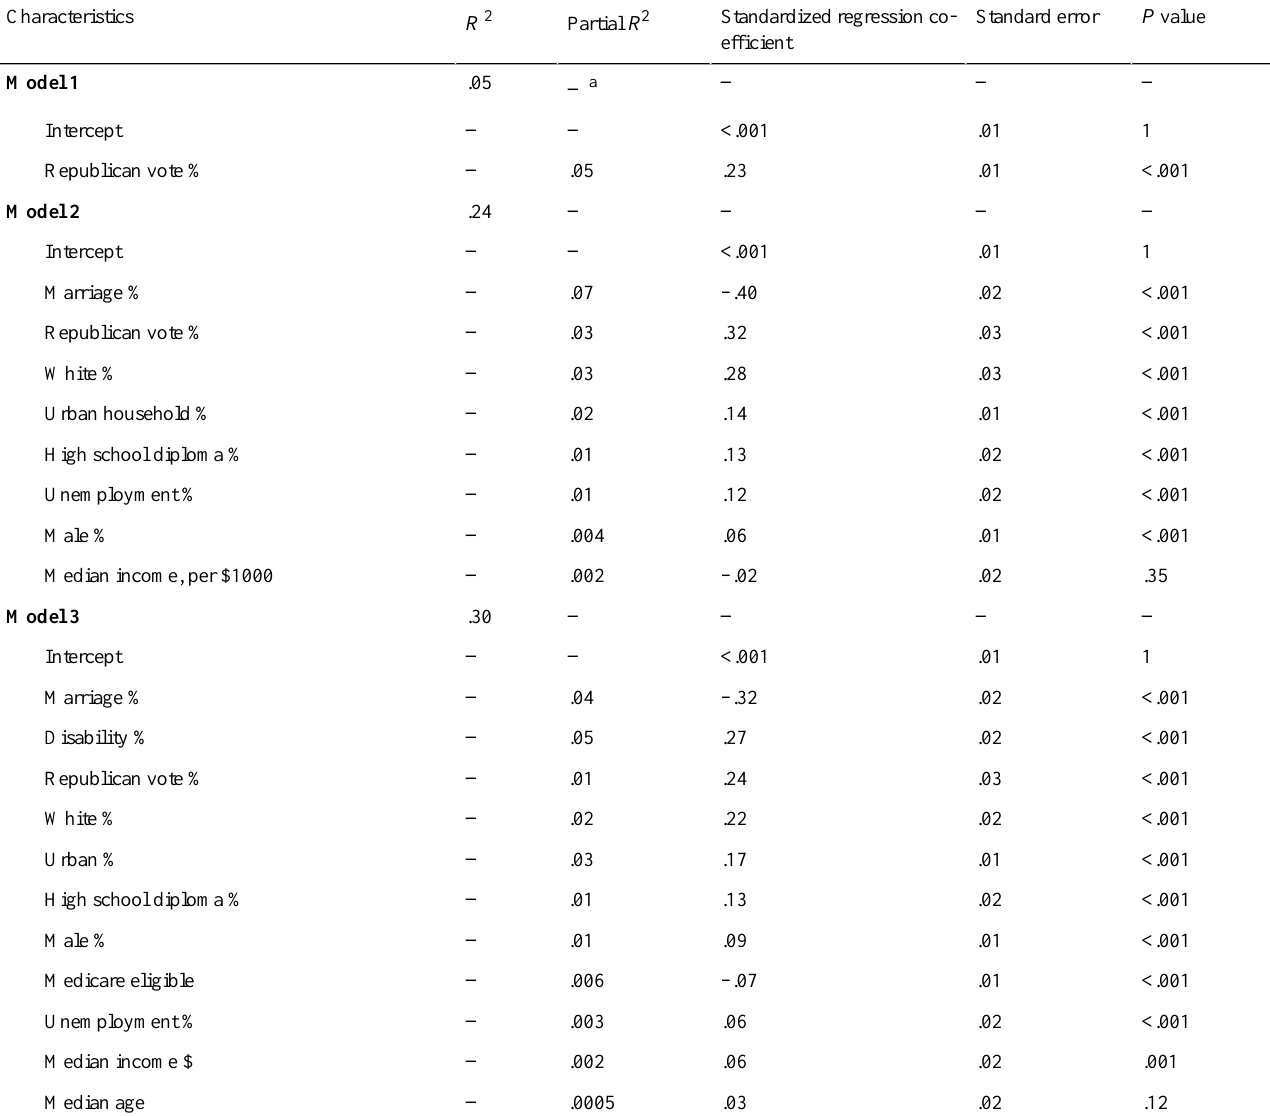
Table 3. Socioeconomic and demographic factors associating the Republican vote with opioid use disorder rates per 100,000 people,